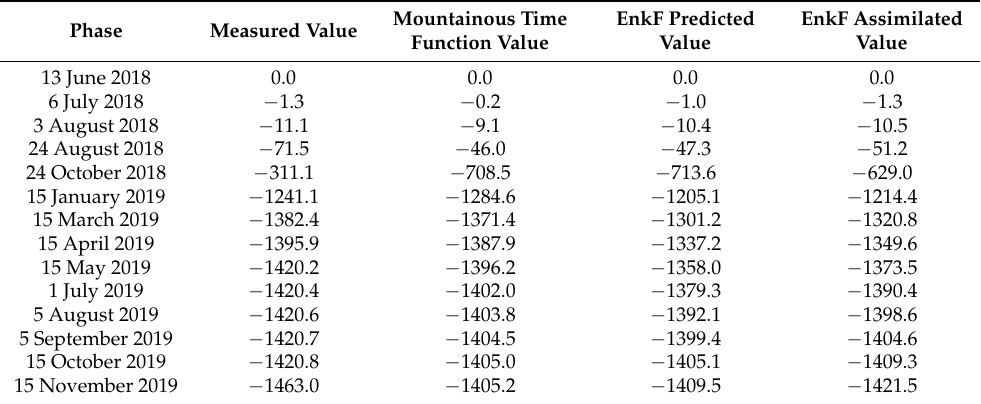
Table A4. The subsidence values of the observation point A29 acquired by different methods